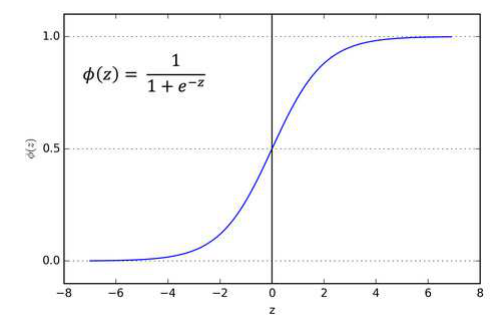
Figure 4. Sigmoid